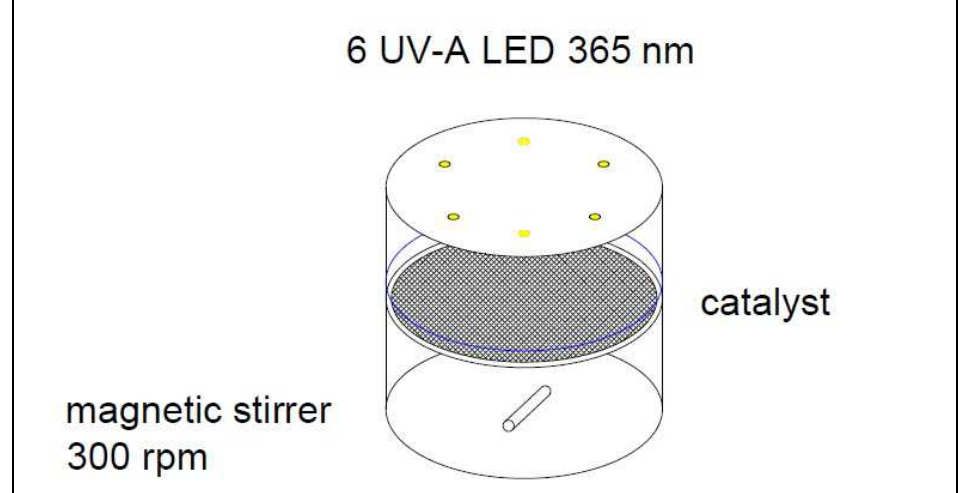
Figure 1. Schematic 3D-Model of the photocatalytic batch reactor.